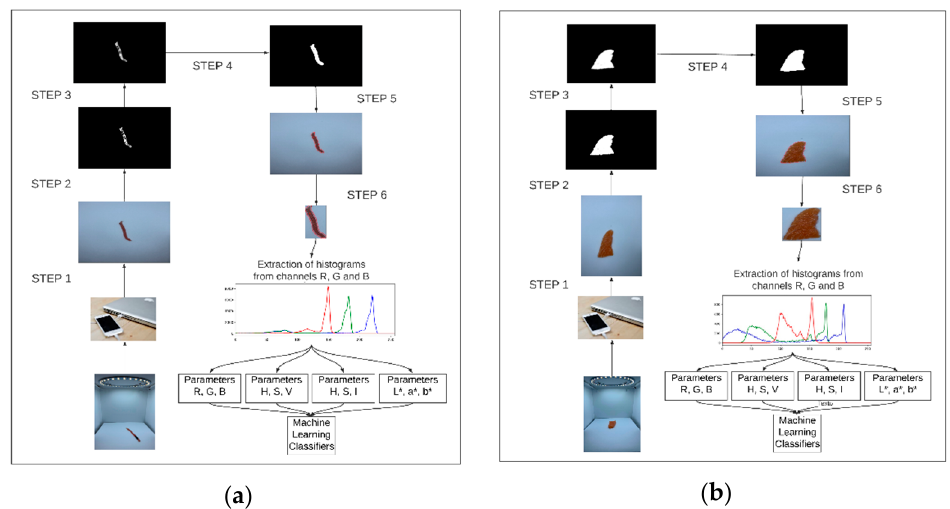
Figure 3. Image preprocessing steps for ( a ) tuna and ( b ) salmon samples. Caption: step 1: resizing the original image to 600 × 400 pixels; step 2: grayscale image, created from the mask that uses a limit for ( a ) red and ( b ) orange variations; step 3: grayscale image, generated from Gaussian filter; step 4: binary image generated from thresholding; step 5: contours defined; step 6: cut the contoured area to determine the region of interest.